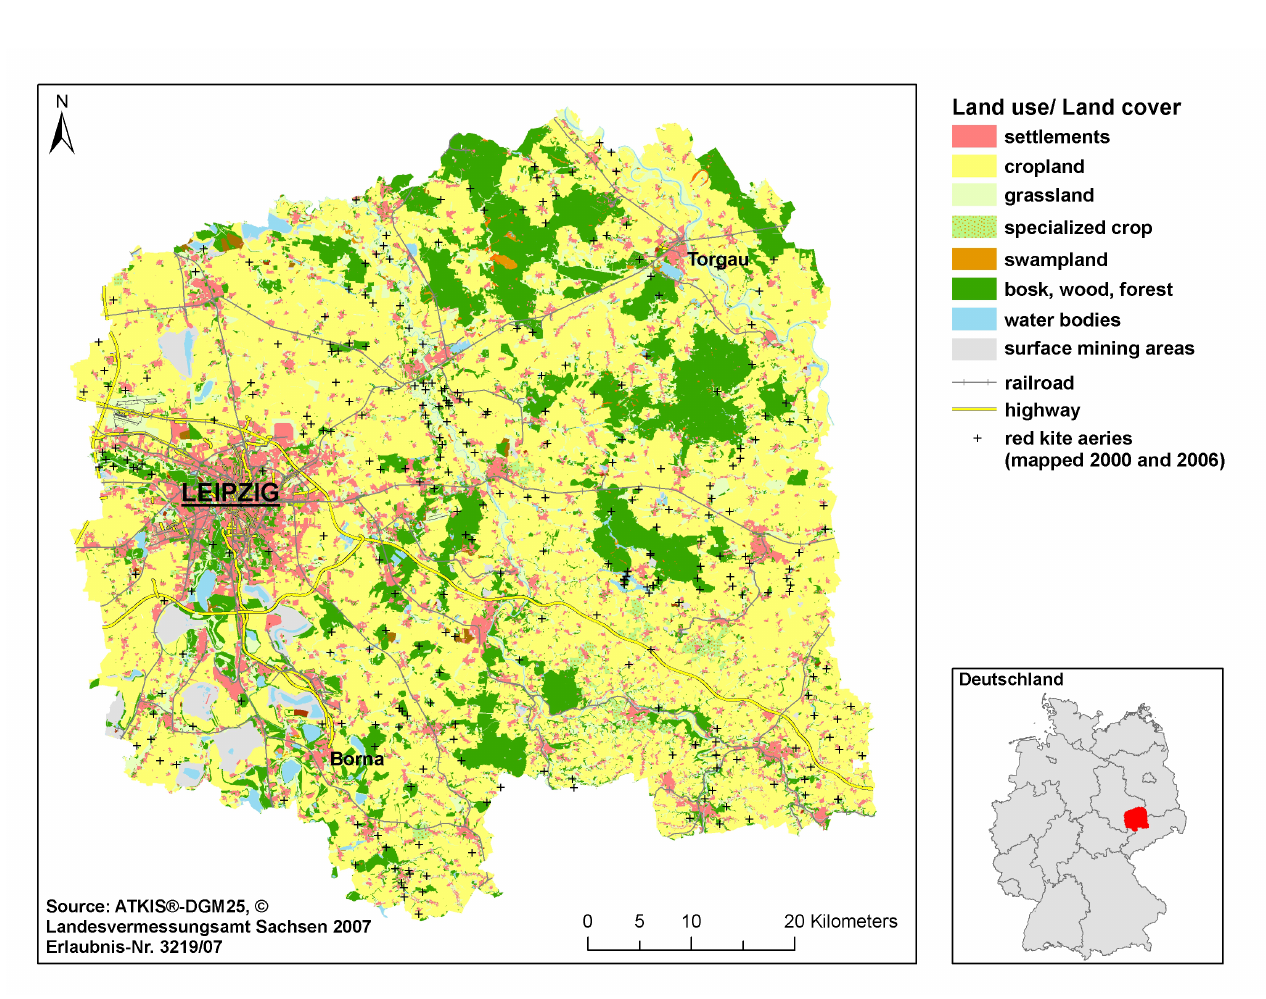
Fig. 1 . The planning region West